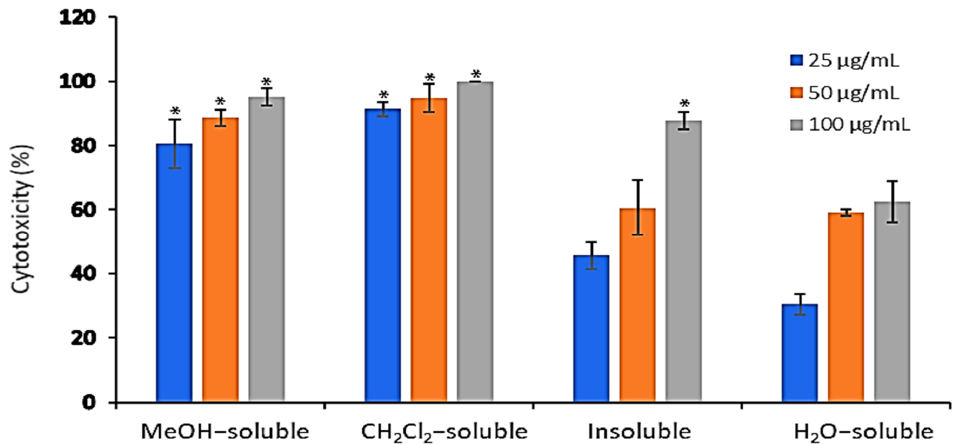
Figure 2. The in vitro cytotoxic effect of A. zerumbet extracts. The cytotoxicity of A. zerumbet extracts (MeOH, CH 2 Cl 2 , insoluble and H 2 O) was evaluated against EAC cells using trypan blue exclusion assay. Three concentrations (25, 50, and 100 µ g / mL) were added on the cells in triplicate and